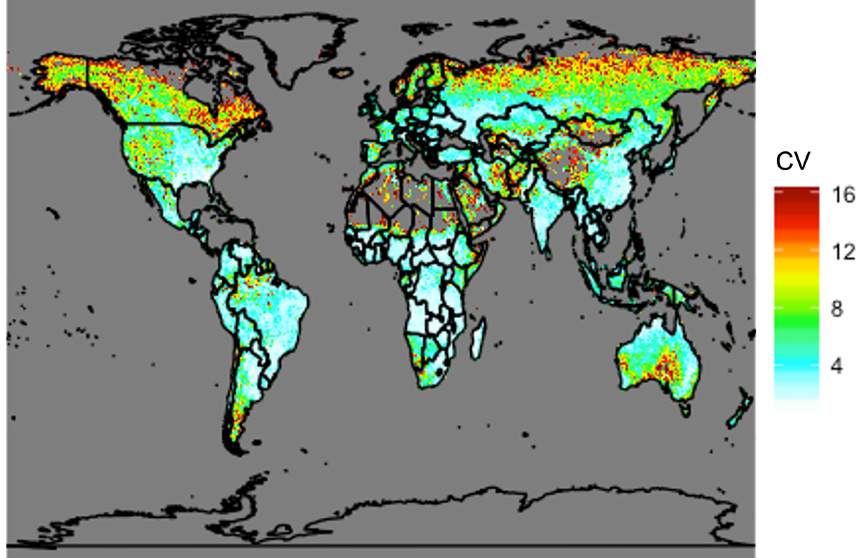
Figure 12. Coefficient of variation (CV) of total annual carbon emissions from fires from 1997 to 2019 using GFED4s DM. Coefficient of variation is defined as the standard deviation of a quantity divided by the mean, which is a statistical measure of the relative dispersion of the dataset about the